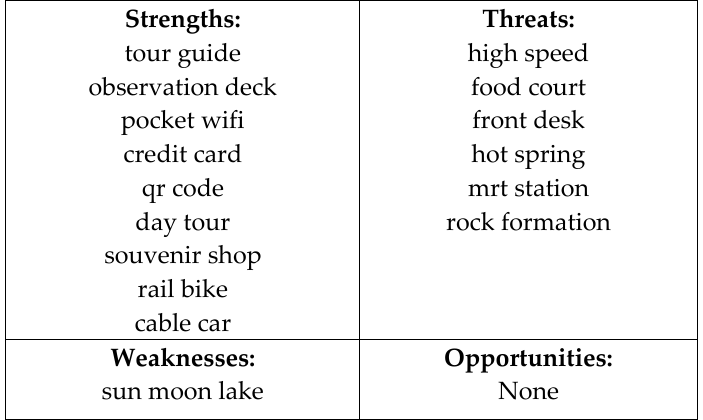
Figure 4. SWOT matrix for KKday.